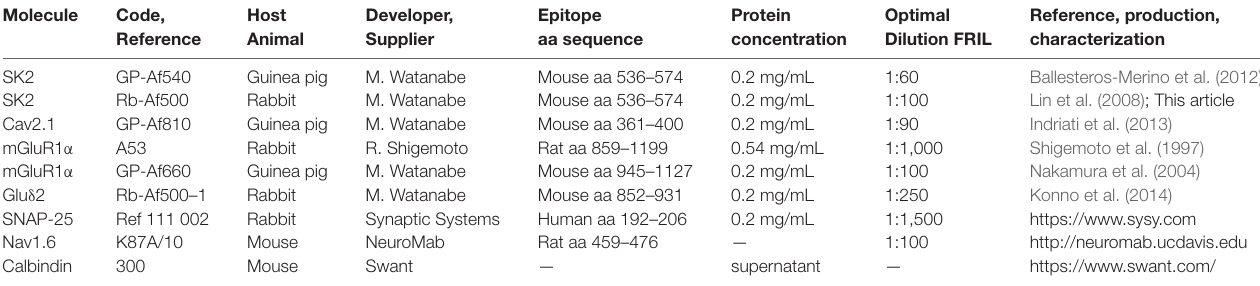
TABLE 1 | Identity, source and characterization of antibodies. Molecule Code, Host Developer, Epitope Protein Optimal Reference, production, Reference Animal aa sequence concentration Dilution FRIL